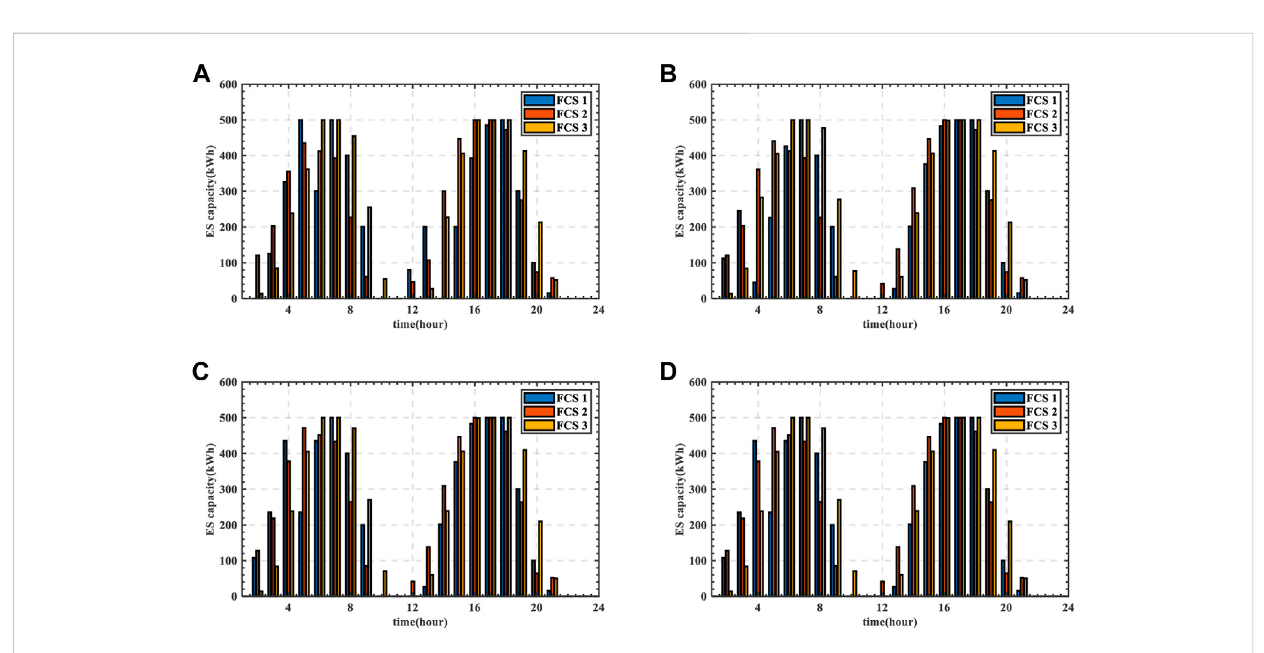
FIGURE 18 ES operation status of scenario four for the shortest travel time